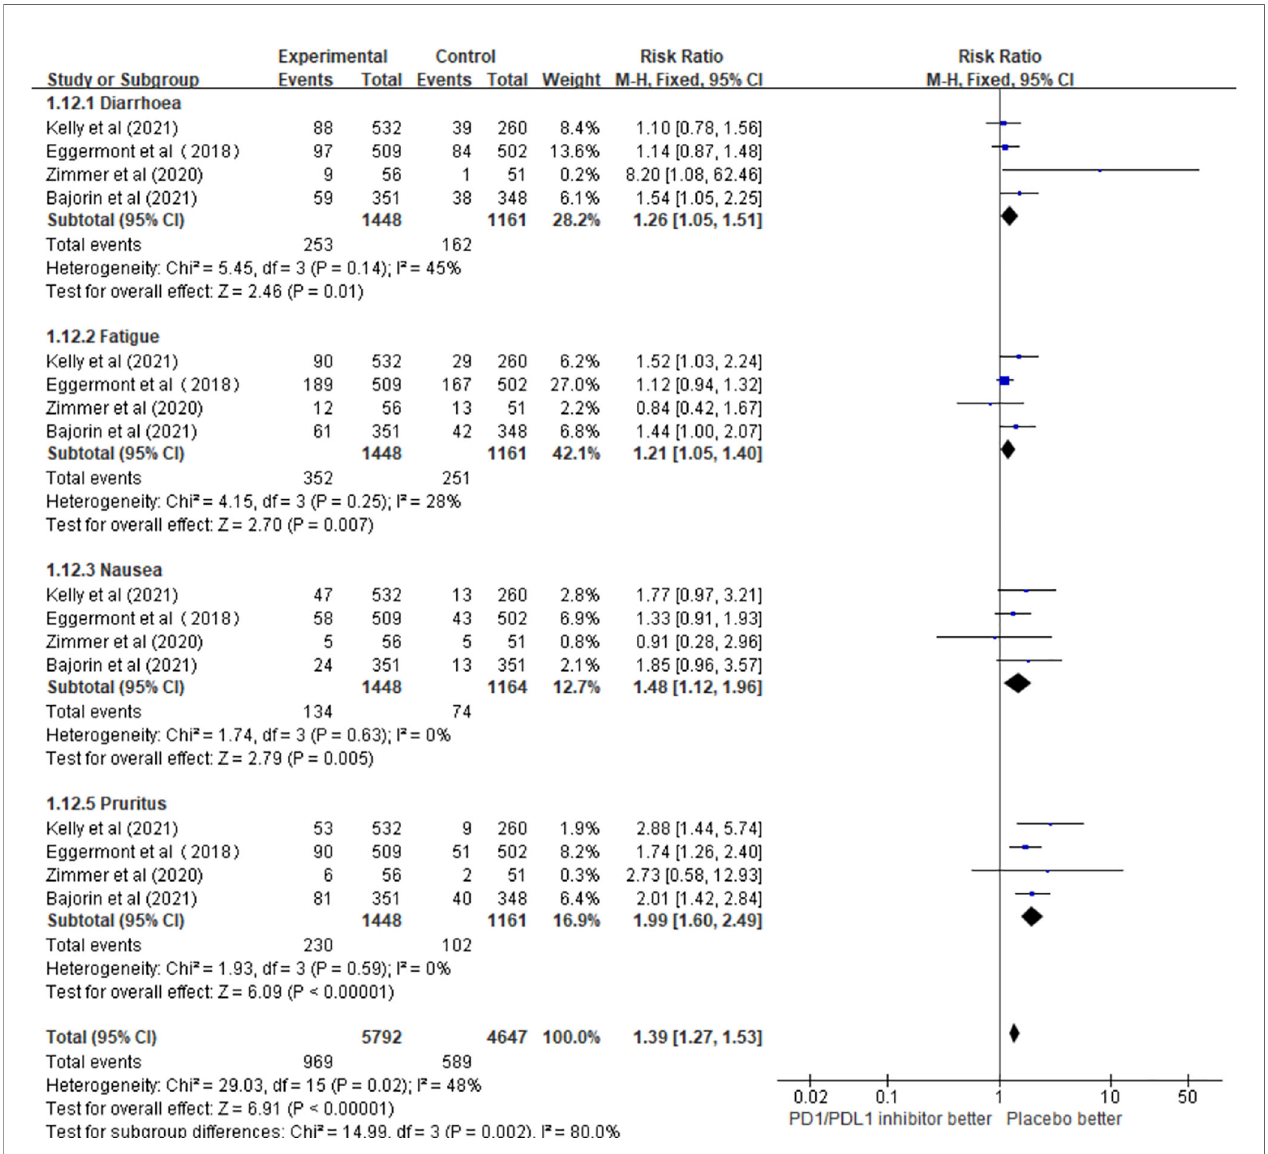
FIGURE 6 | The incidence of different adverse events in the PD1/PDL1 inhibitors groups and placebo